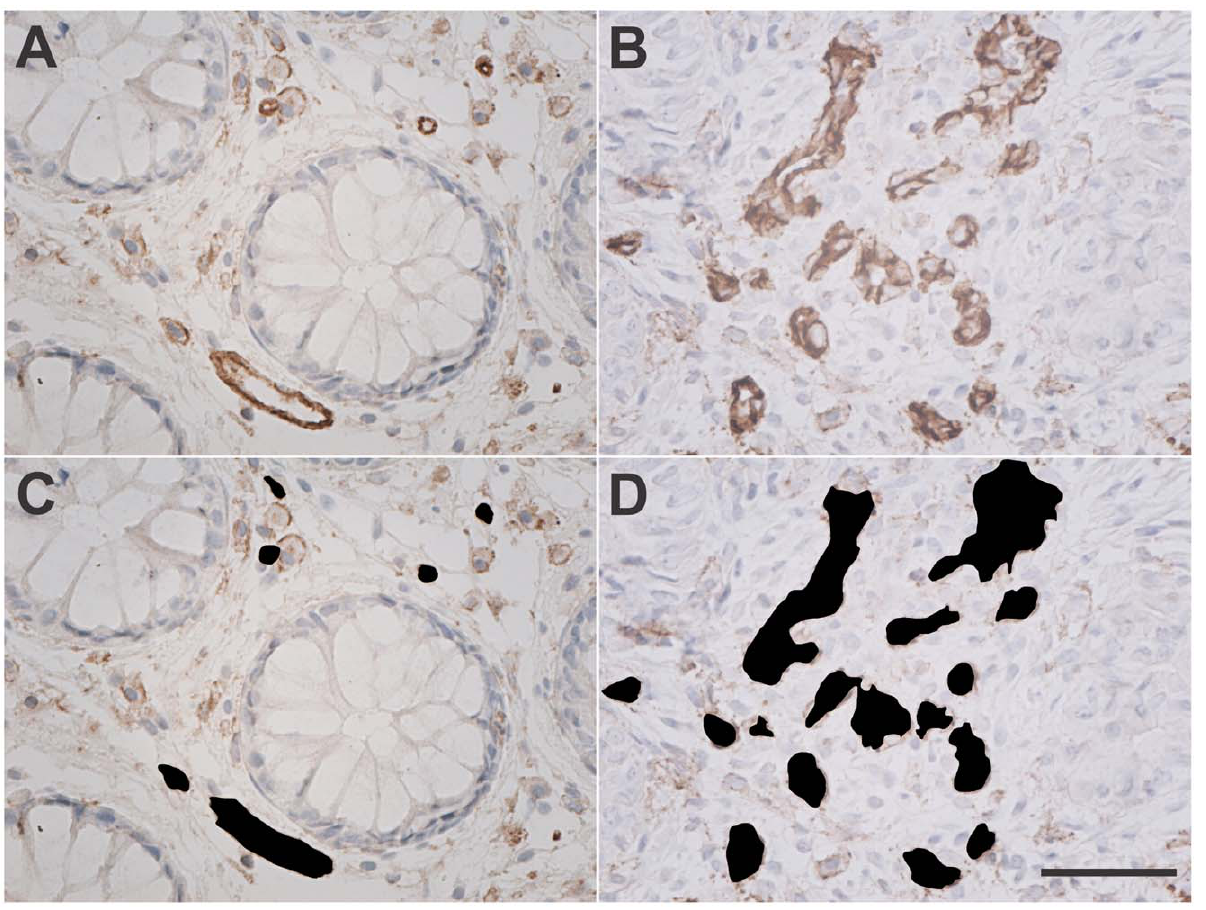
Figure 3. Immunohistochemical staining for CD31. Bright field images of the formalin fixed and paraffin embedded biopsies of normal and primary colonic cancer stained for CD31 showing: blood vessels regularly distributed between the intestinal glands in the normal colonic mucosa (A); multiple irregular vessels in the intratumoral stroma, in malignant samples (B); the same images with vascular areas marked for automated counting (C, D).*Scale bar is 50 m m.